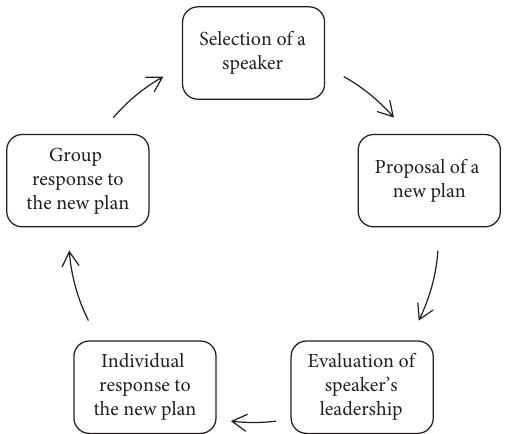
Figure 2: A speaking cycle made of five steps of group planning used in our